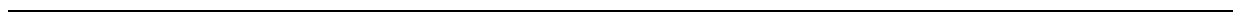
Fig. 4 Reduction of Dkk3 level rescued age-related muscle atrophy. a Adenovirus-encoding shRNA against Dkk3 was injected to TA muscles in old mice (20 months) intramuscularly. Adenovirus-encoding scramble shRNA was injected to the TA muscle in a mouse with the same age and gender as control. Both pieces of shRNA were co-expressed with GFP to label the infected muscle fi bers in vivo. Injections were performed once a day for 7 continuous days. TA muscles were harvested at day 14 for further analysis. b Gene expression levels of Dkk3 , Fbxo32 , and Trim63 in TA muscles injected with shRNA against Dkk3 or scramble control as indicated by RT-qPCR. Error bars indicated s.d. and were based on fi ve independent experiments. ** indicated p < 0.01. c Representative immuno fl uorescent staining images of muscle cross sections derived from TA muscles in old mice treated with shRNA against Dkk3 or scramble control. The cross areas of all 1500 fi bers in each TA muscle were checked. Red indicated laminin staining; green indicated GFP; DAPI indicated nuclei; merge indicated merged images of laminin, GFP, and DAPI staining. Scale bars, 50 μ m. d Percentage distribution of muscle fi ber cross section area derived from muscles treated with shRNA against Dkk3 or scramble control. Black dots indicated muscle sections with scramble control treatment. Gray squares indicated muscle sections with Dkk3 RNAi. e The percentage of TA muscle (by weight) in whole body muscles derived from mice treated with shRNA against Dkk3 or scramble control. Error bars indicated s.d. and were based on fi ve independent experiments. ** indicated p < 0.01. f Speci fi c titanic force of TA muscles treated with shRNA against Dkk3 or scramble control in old mice (20 months). The speci fi c titanic force of TA muscles in old mice were compared to that of young mice (3 months). g 1/2 relaxation time of TA muscles treated with shRNA against Dkk3 or scramble control in old mice (20 months). 1/2 relaxiation time of TA muscles in old mice were compared to that of young mice (3 months). All error bars indicated s.d. based on 5 independent experiments. ** indicated p < 0.01. * indicated p < 0.1. NS indicated no signi fi cant changes. All p -values were based on two-tailed t